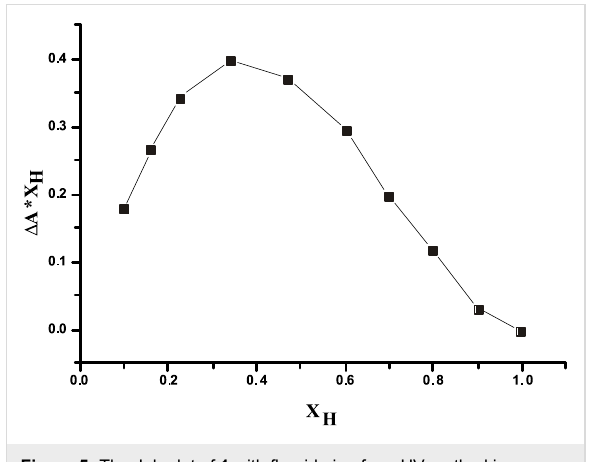
the acidity of the H-bond donor site and the particular stability of the [HF 2 ] − ion. The stoichiometry of 1 with F − was deter- mined to be 1:2 from the Job plot [48] (as shown in Figure 5).